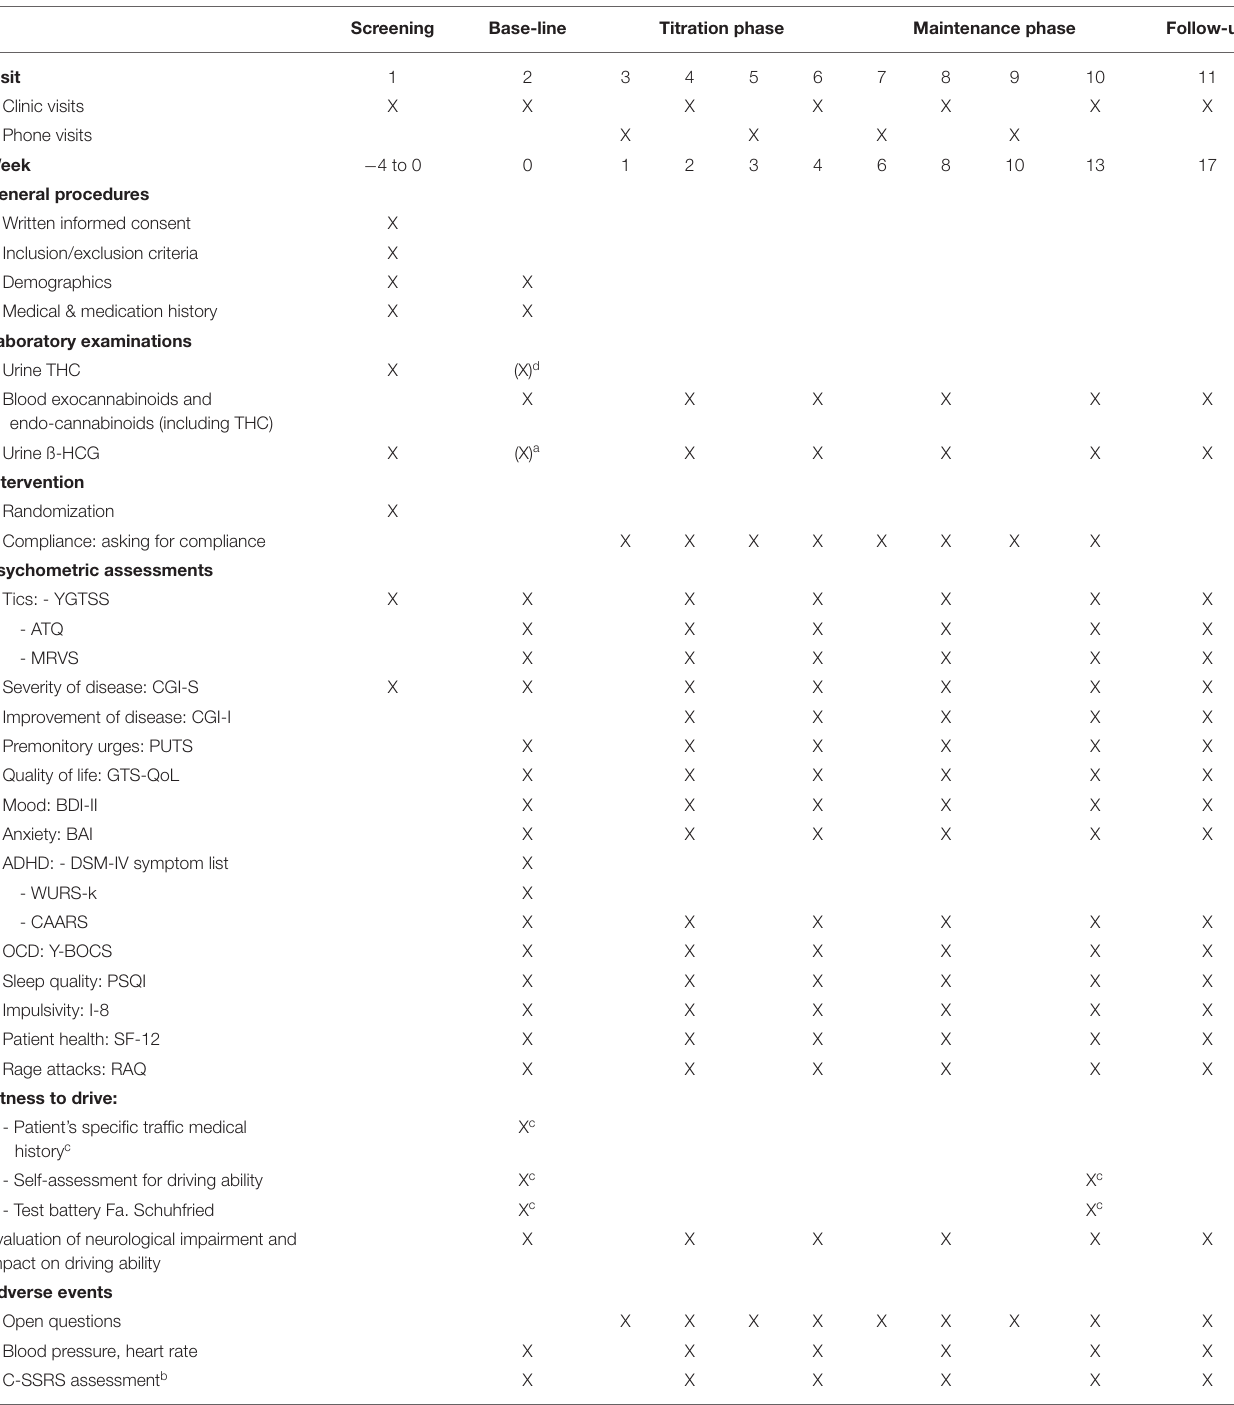
TABLE 1 | Schedule of Study Assessments and Visits. Screening Base-line Titration phase Maintenance phase